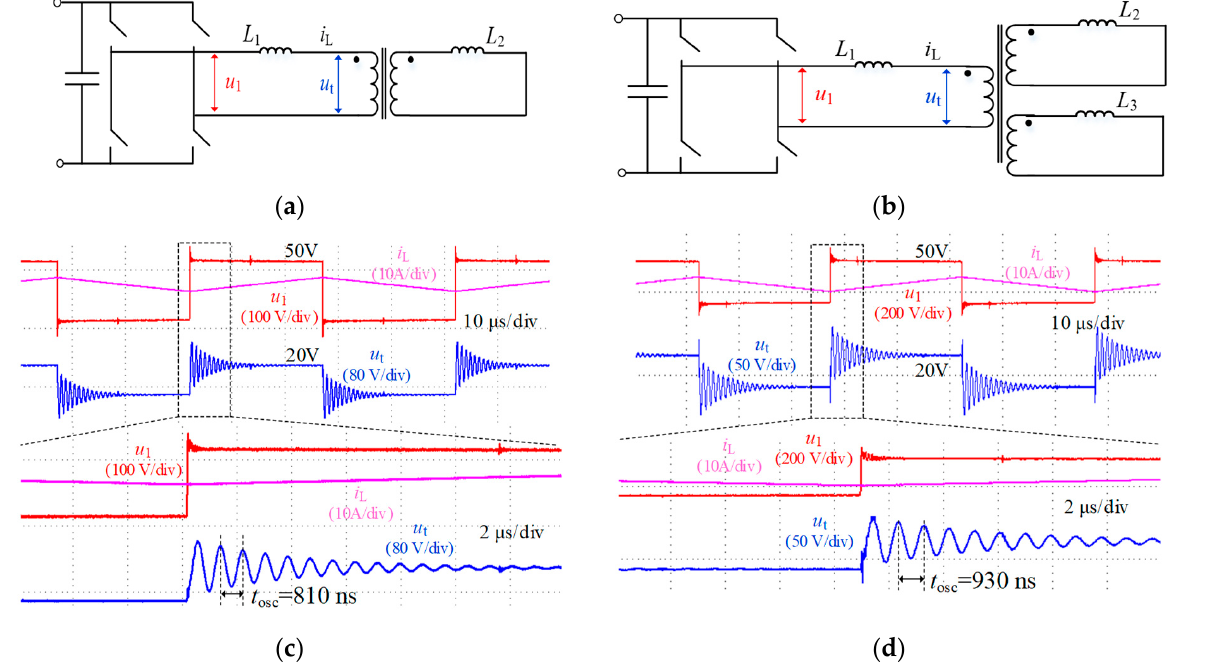
Figure 7. Short ‐ circuit test. ( a , c ) Test circuit and waveforms of the DAB converter; ( b , d ) test circuit and waveforms of the TAB converter.